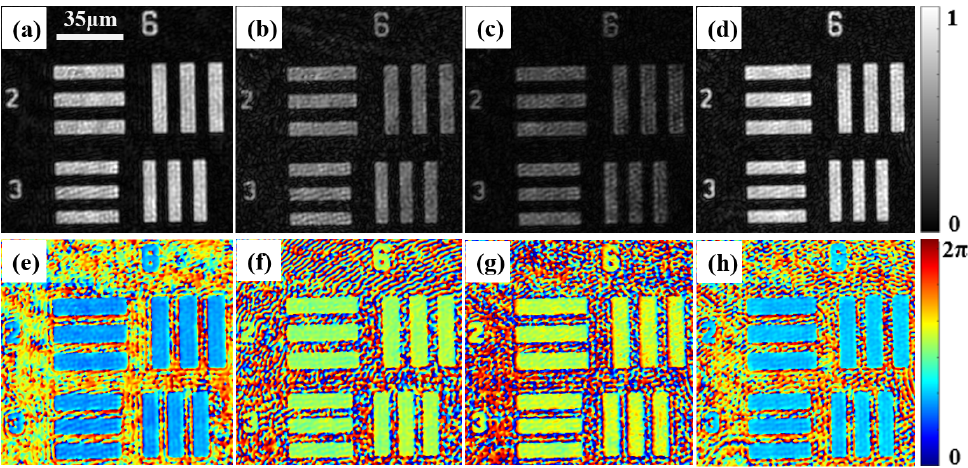
Figure 4. Measured Jones matrix parameters of a USAF 1951 resolution test target. ( a – d ) The amplitude distributions of the four Jones matrix parameters corresponding to T , respectively; ( e – h ) are their corresponding phase distributions.